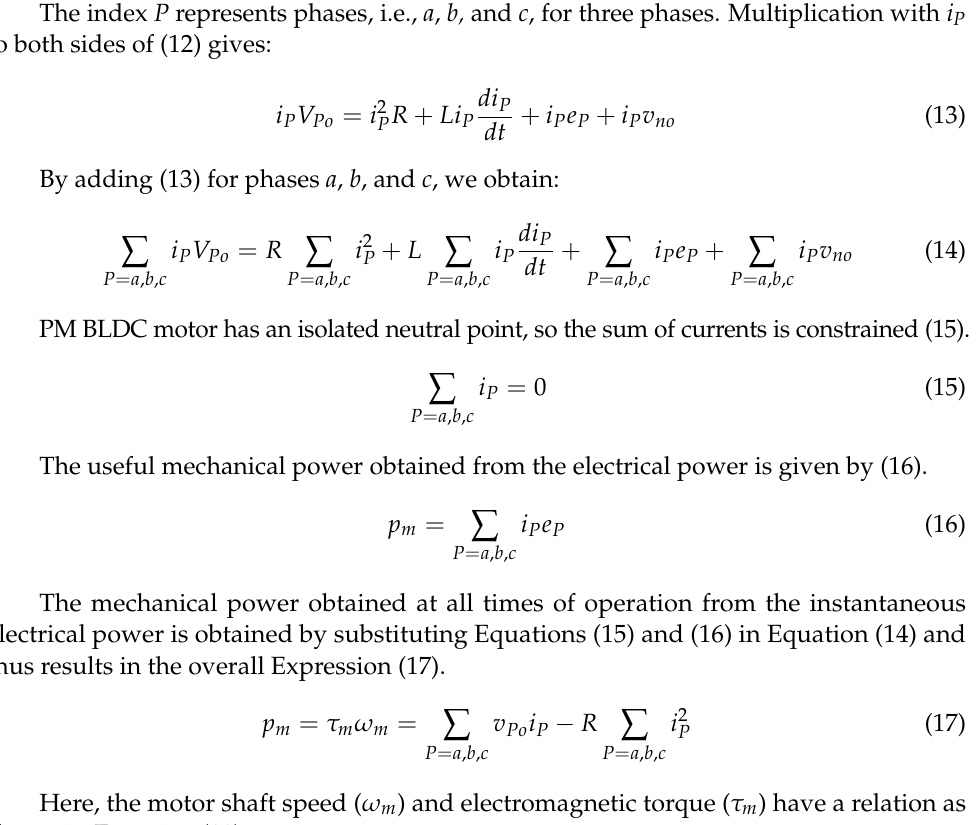
Here, the motor shaft speed ( ω m ) and electromagnetic torque ( τ m ) have a relation as shown in Equation (18).